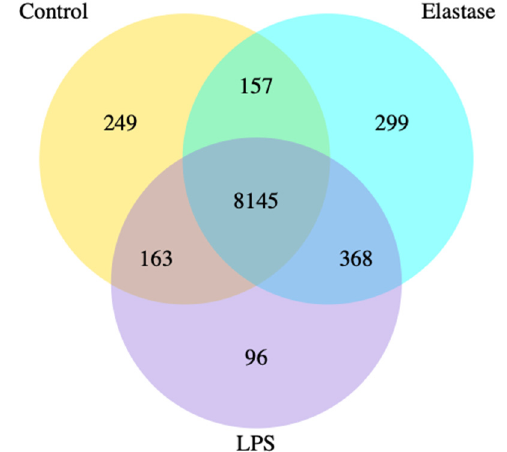
Figure 1. Co-expression Venn diagram. Pregnancy neutrophils were obtained at approximately 30 weeks’ gestation and treated with elastase or lipopolysaccharide (LPS). Elastase treatment resulted in 3 times more uniquely expressed genes than LPS. A total of 299 were uniquely expressed with elastase as compared to 96 for LPS.